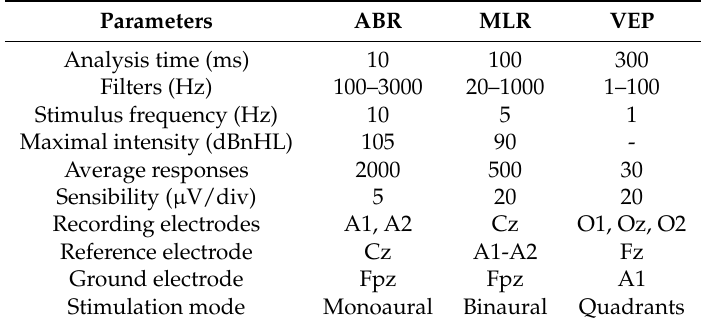
Table 2. Recording conditions of auditory responses and visual evoked